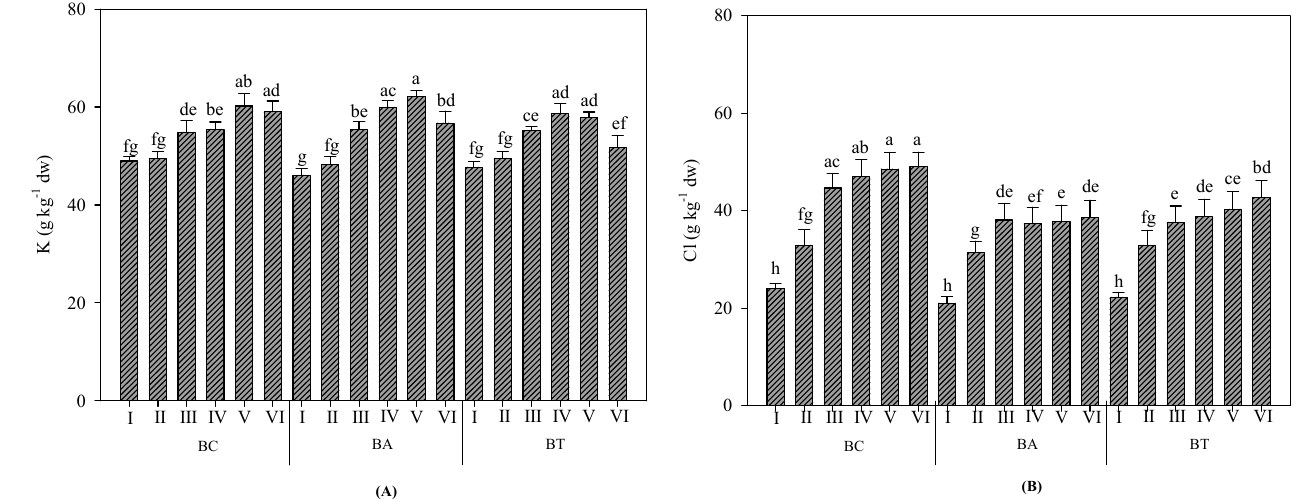
Figure 3. Effect of biostimulants and harvesting time on minerals K ( A ) and Cl ( B ) in Diplotaxis tenuifolia leaves, regardless of salinity level. Different letters indicate significant differences according to Tukey’s honestly significant difference (HSD) test at p = 0.05. Roman numbers (I–VI) indicate the successive harvests. BC: no biostimulants added; BA: plants treated with Auxym®; and BT: plants treated with Trainer®. All data are expressed as mean ± SE (standard error), n = 3.